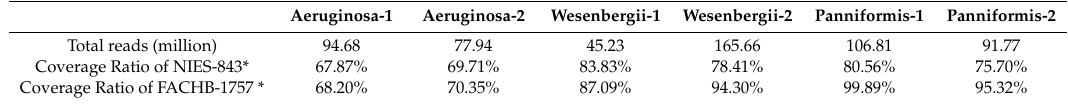
Table 1. Data summary and mapping results.